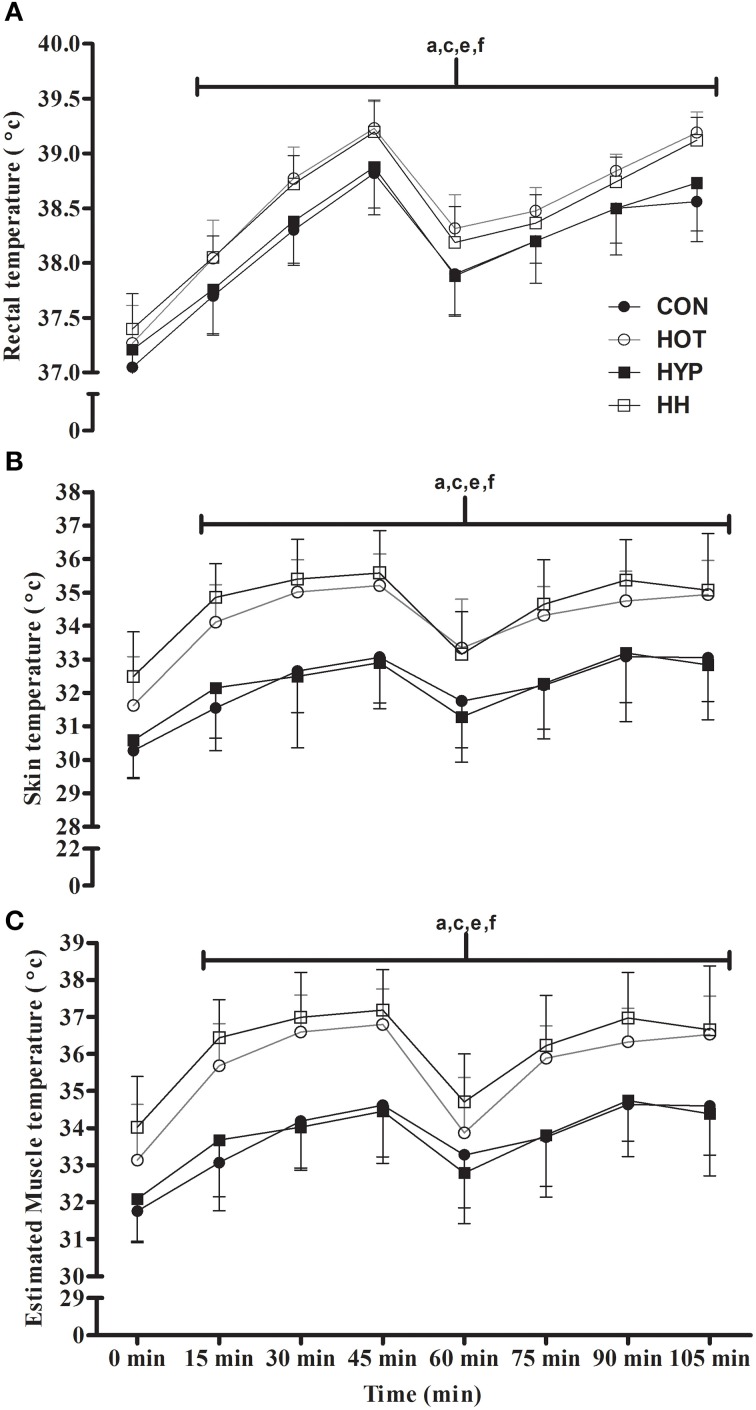
The Tre (A), Tsk (B), and Tmu (C) during the first (0–45 min) and second (60–105 min) half in CON, HOT, HYP, and HH. All body temperatures were significantly increased (p < 0.05) in HOT and HH compared with CON and HYP from 15–105 min. aSignificant difference between CON and HOT (p < 0.05); cSignificant difference between CON and HH (p < 0.05); eSignificant difference between HYP and HH (p < 0.05); fSignificant difference between HOT and HYP (p < 0.05).